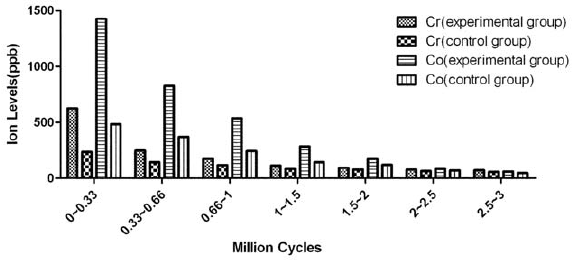
Figure 5. Volumetric wear rates during 0–1,1–2 and 2–3 MC.